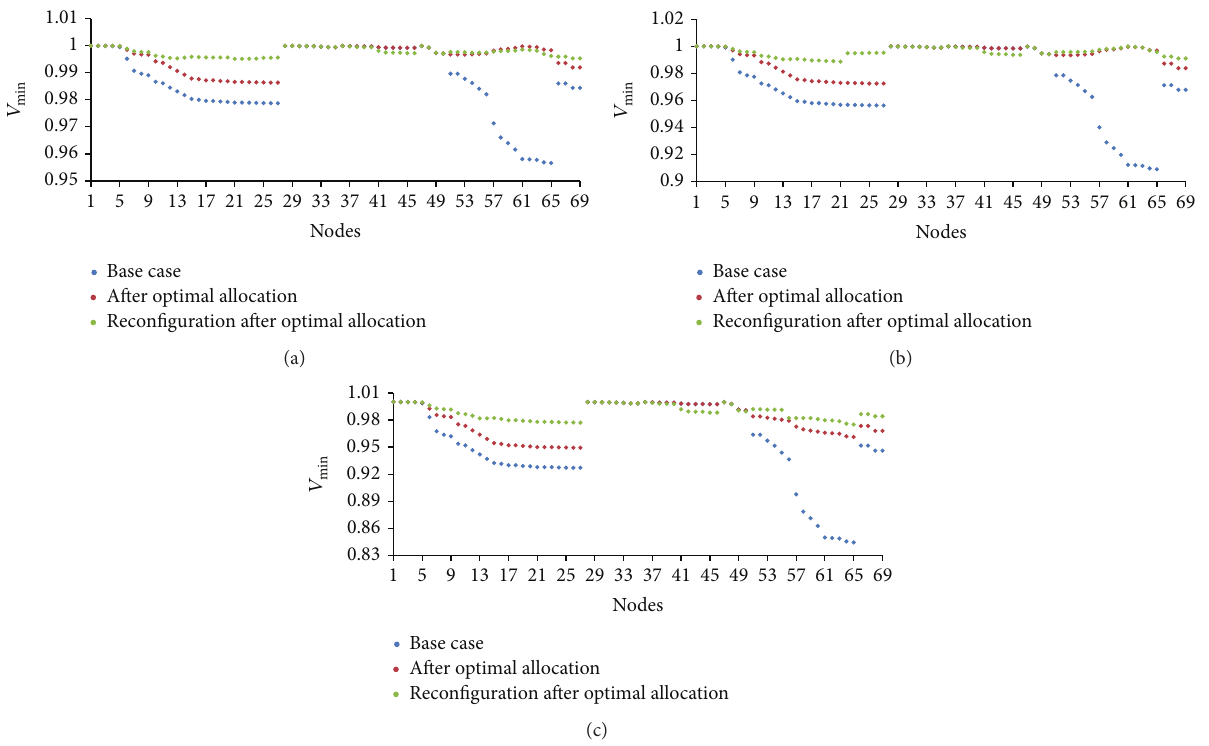
Figure 6: Comparison of voltage profiles for base case, after optimal allocation of devices and reconfiguration after optimal allocation of devices at (a) light load, (b) nominal load, and (c) peak load.